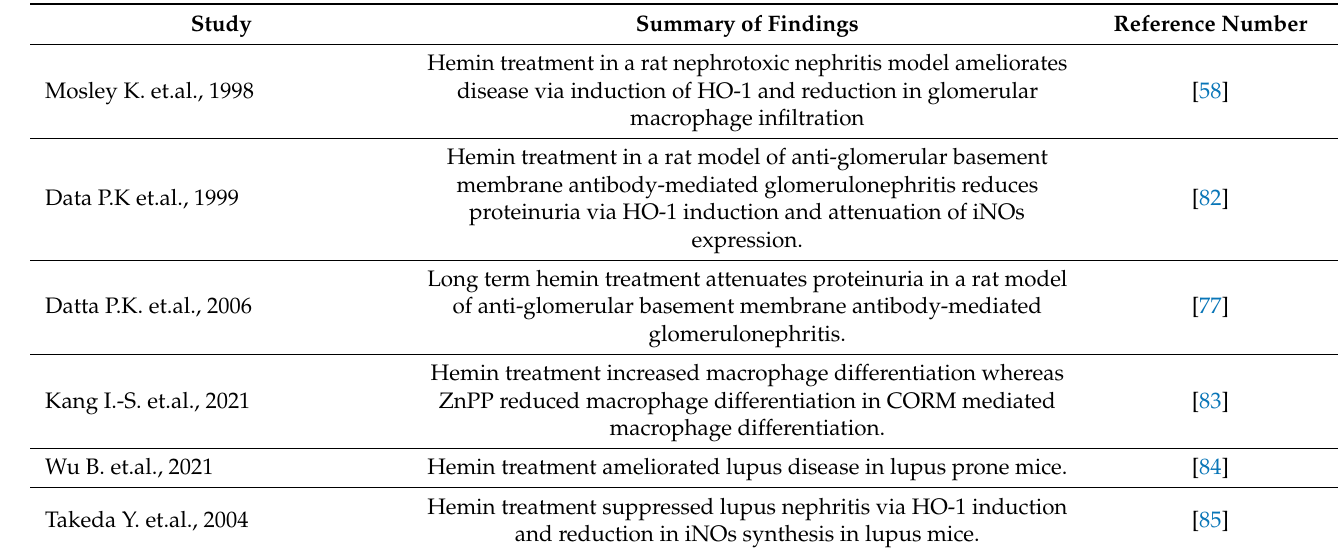
Table 1. Mp effects on immune-mediated kidney injury in animal disease